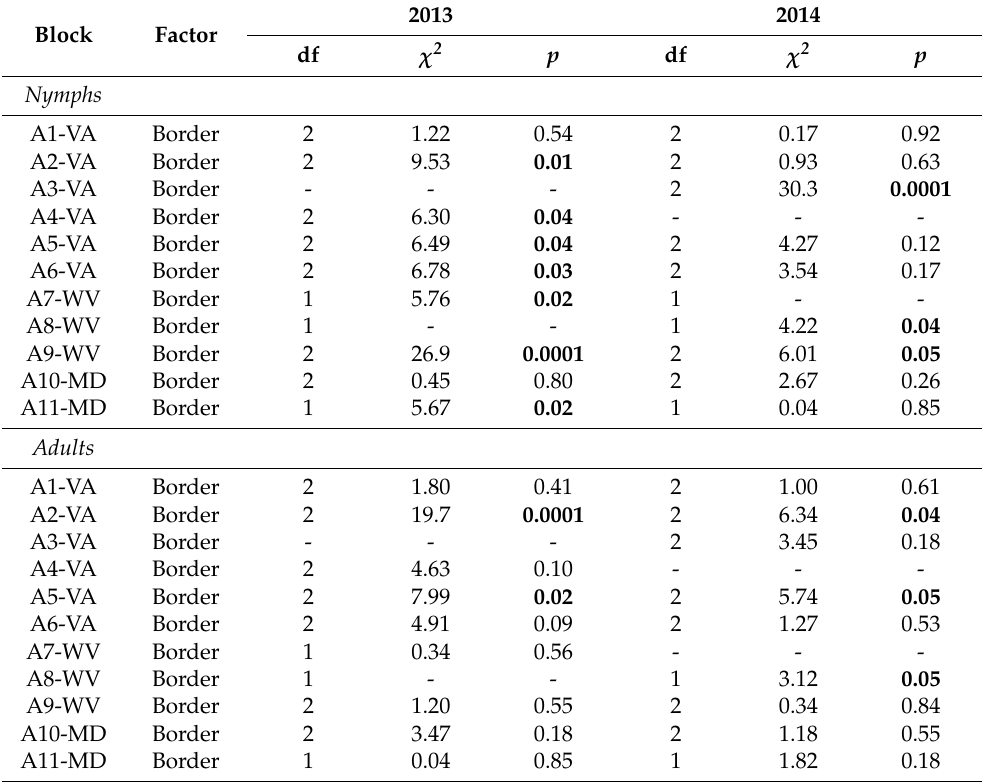
Table 2. Summary of statistical results for captures of H. halys nymphs and adults in pheromone- baited traps on the edges of 9 apple blocks per year (2013 and 2014) in the Mid-Atlantic, USA. Significant p values are highlighted in bold